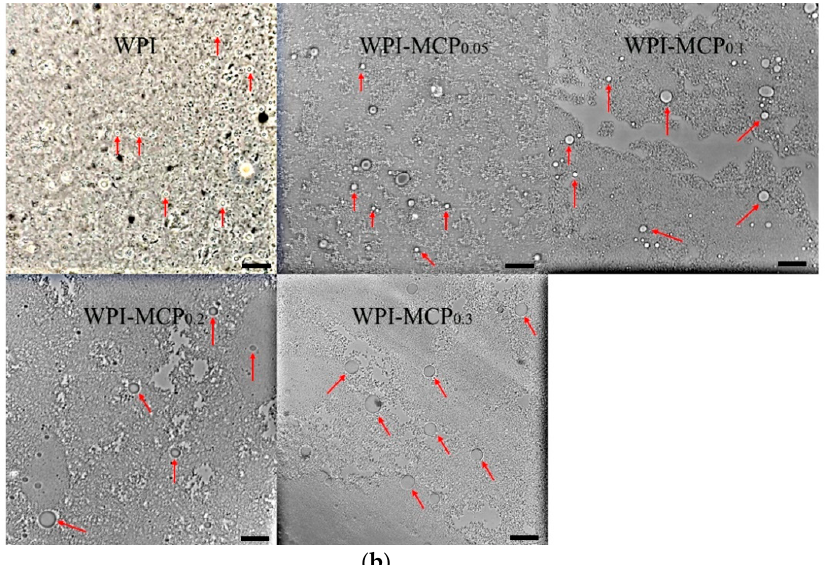
Figure 3. Typical CLSM ( a ) and light microscope images ( b ) of the emulsions stabilized by WPI (2%, w / v ) with different concentration of MCP from 0 to 0.3% ( w / v ). For ( a ), from left to right were corn oil staining with Nile red, protein staining with Nile blue, and the combined images, respectively. The blue bars in ( a ) and black bars in ( b ) represent 25 μ m and 20 μ m in scale. The red arrows mark emulsion droplets.